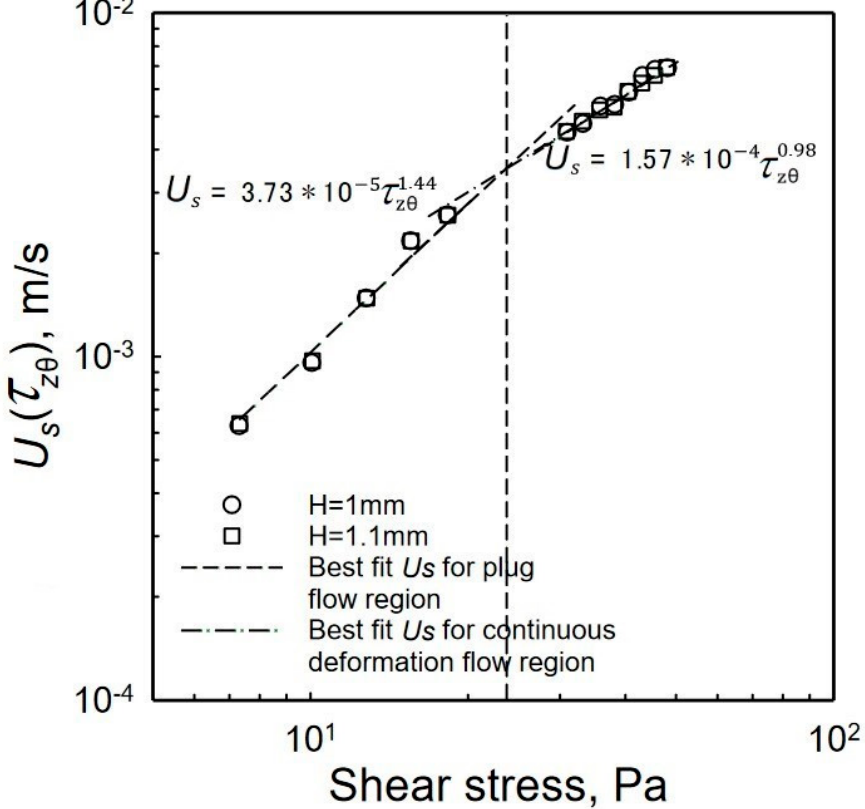
Figure 10. Wall slip velocity, U s , versus shear stress at the edge, | τ z θ ( R ) | , for two gaps from the data collected via PIV experiments [98]. The slope is equal to 3.73 × 10 − 5 m/(Pa 1.44 s) for plug flow region and 1.573 × 10 − 4 m/(Pa 0.98 s) for continuous deformation